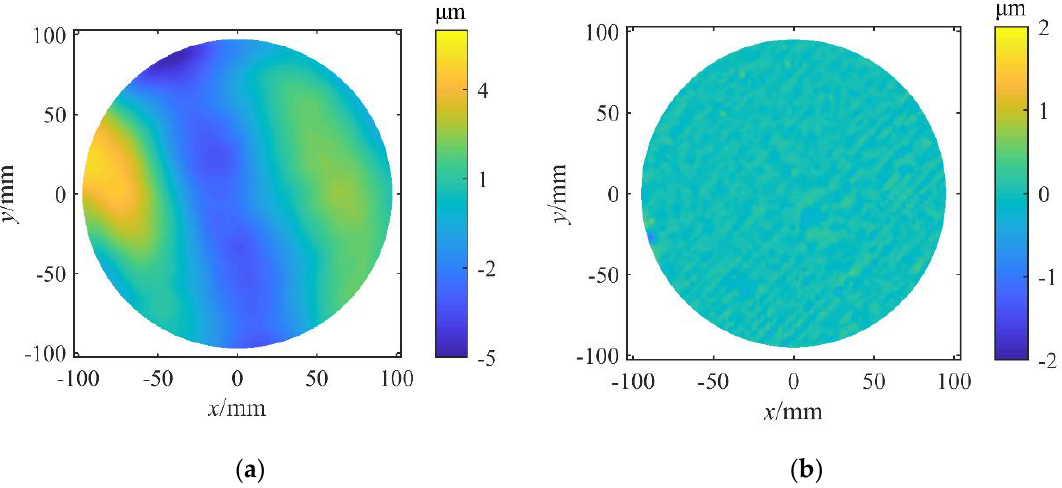
Figure 3. Simulated wafer deformation ( a ) and the difference from measured deformation ( b ).